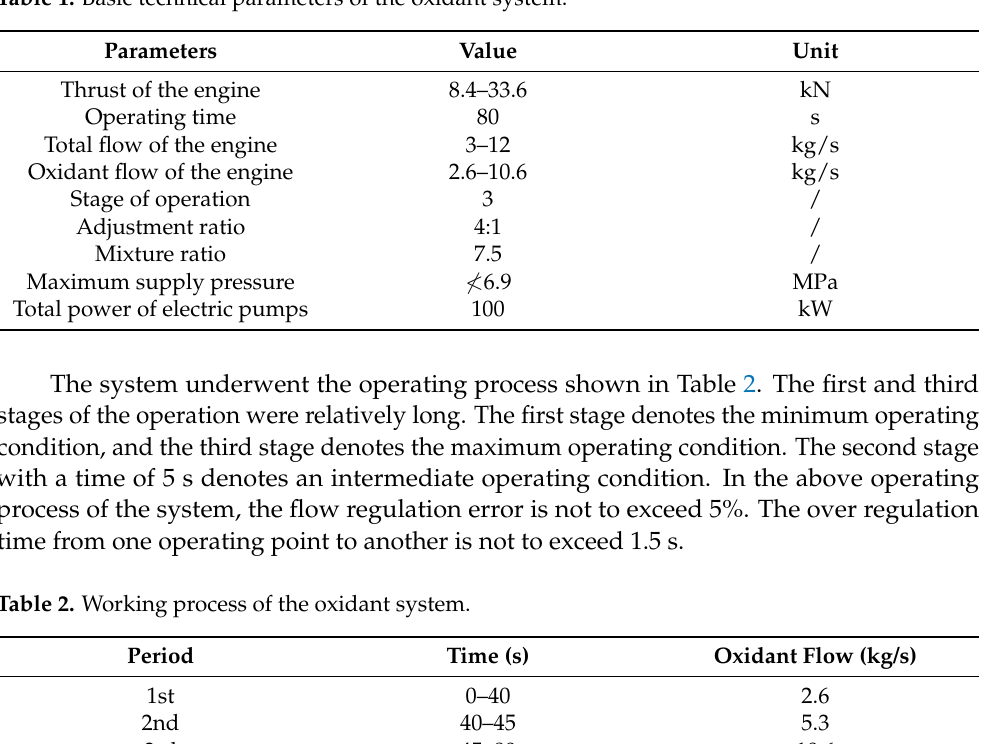
Table 1. Basic technical parameters of the oxidant system.